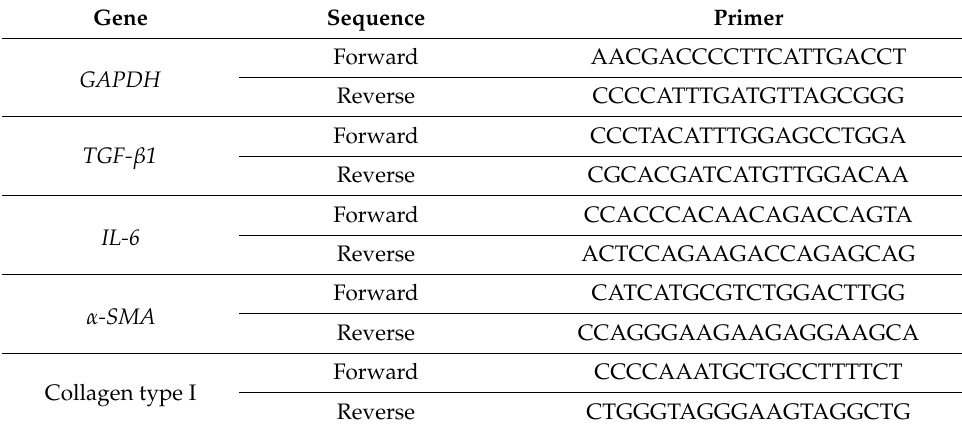
Table 1. Genes and primer sequences used for